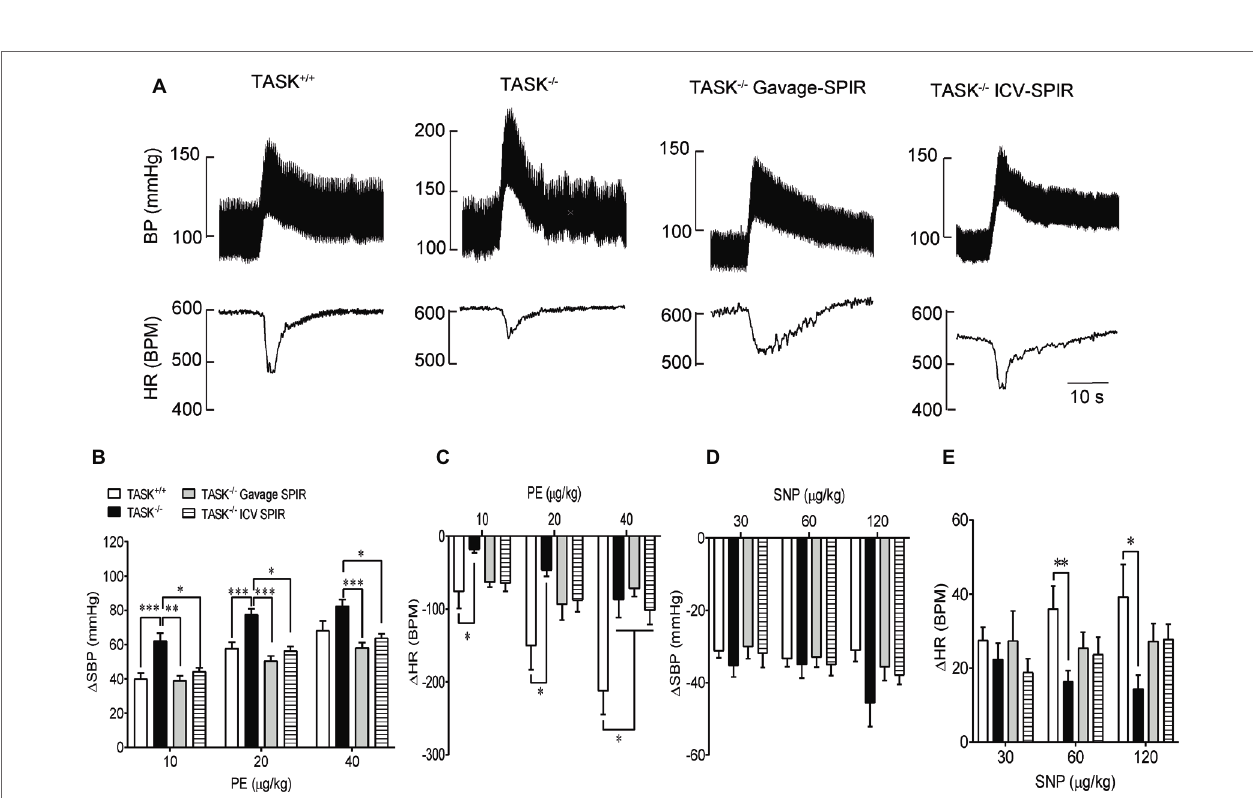
FIGURE 6 | Baroreceptor reflex function. The baroreflex function was measured pharmacologically in anesthetized TASK +/+ and TASK − / − mice. (A) Typical traces showing responses of BP and HR to intravenous injection of PE. (B,C) The mean change in SBP ( Δ SBP) and HR ( Δ HR) in response to intravenous injection of PE. Statistical analysis reported significant effects of dose and genotype as indicated by asterisks. n = 18 mice/48 responses for TASK +/+ , n = 12 mice/31 responses for TASK − / − , n = 10 mice/30 responses for TASK − / − with gavage of SPIR, n = 12 mice/36 responses for TASK − / − with ICV injection of SPIR. (D,E) The mean change in SBP pressure ( Δ SBP) and HR ( Δ HR) in response to intravenous injection of SNP. n = 18 mice/41 responses for TASK +/+ , n = 12 mice/34 responses for TASK − / − , n = 10 mice/30 responses for TASK − / − with gavage of SPIR, n = 12 mice/33 responses for TASK − / − with ICV injection of SPIR. * p < 0.05, ** p < 0.01, *** p < 0.001 as indicated, one-way ANOVA with Tukey’s multiple comparisons test. PE, phenylephrine; SNP, sodium nitroprusside.